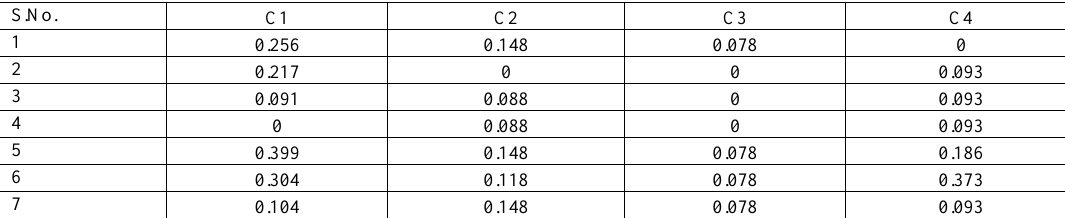
Table 10. Weighted decision matrix